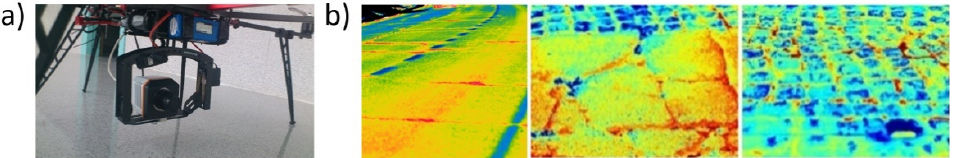
Figure 3. IRT. ( a ) A thermographic camera mounted on an UAV and ( b ) examples of thermograms showing superficial pathologies in pavements (adapted from (Lagüela et al., 2018)). showing superficial pathologies in pavements (adapted from